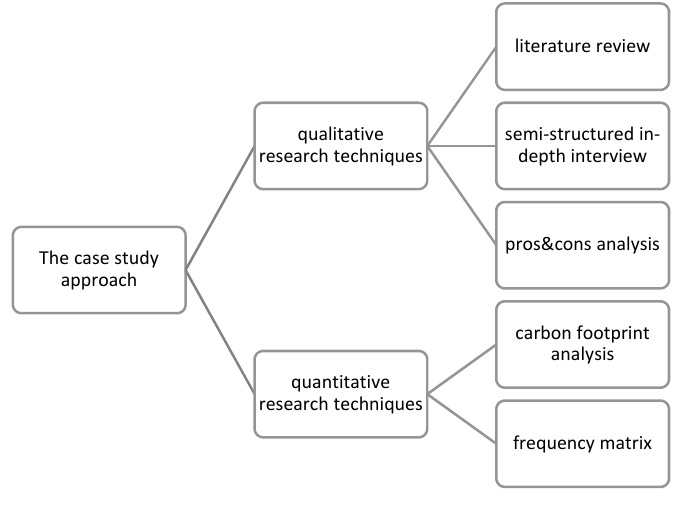
Figure 1. The case study research design.